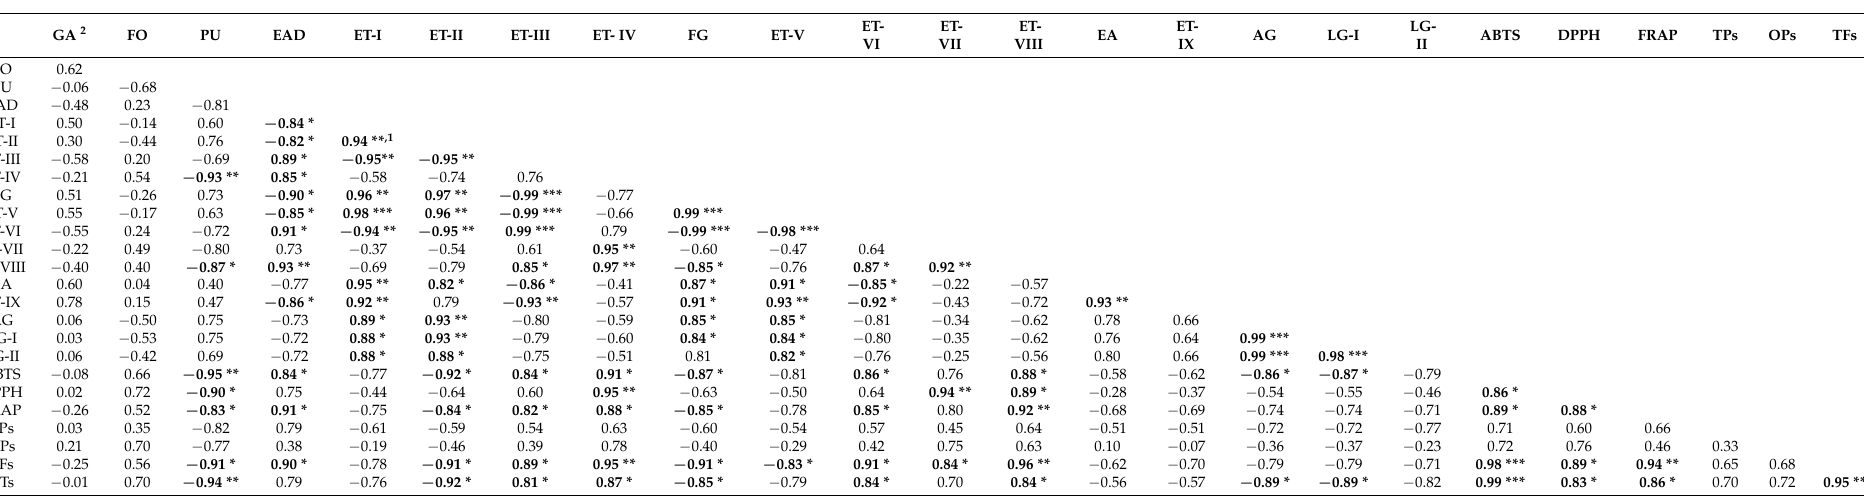
Table 3. Pearson correlation coefficient ( r ) between various phenolic compositions and